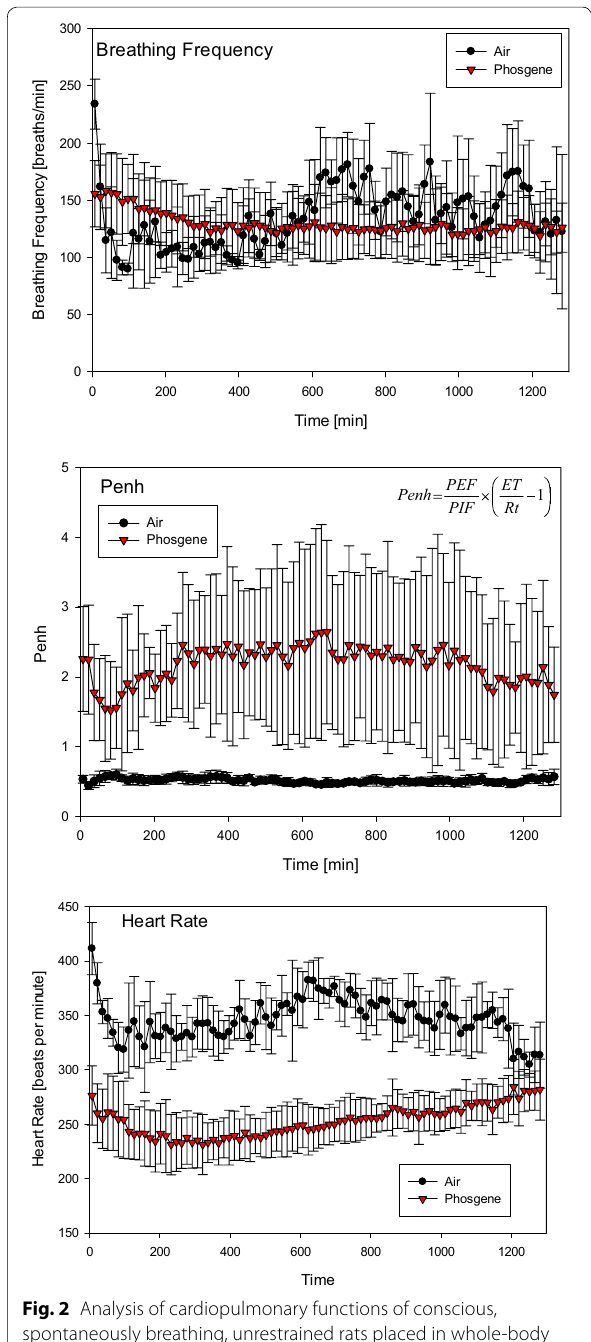
Fig. 2 Analysis of cardiopulmonary functions of conscious, spontaneously breathing, unrestrained rats placed in whole-body barometric flow-plethysmographs (food and water accessible) from the end of exposure to phosgene until the next morning during a data collection-period of 20 h. Measurements focused on respiratory rate, enhanced pause (Penh) and heart rate using radiotelemetry transmitters intra-peritoneally placed in a single lead II configura- tion (DSI PhysioTel ® Implantable Telemetry System). Data represent means SD from eight rats/group (averaged during collection ± periods of 15 min). Insert ( mid panel ): Penh is a unitless index that was used to evaluate changes in the shape of the airflow patterns as index of changes in the control of breathing secondary to